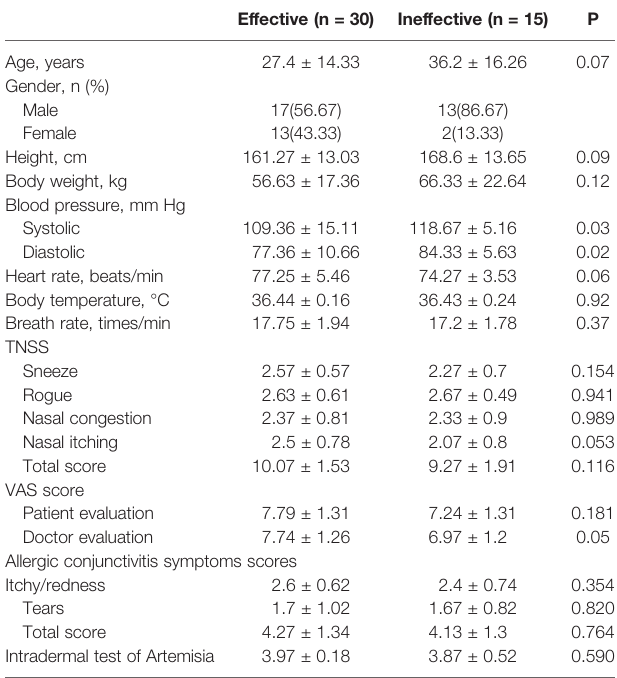
TABLE 1 | Baseline characteristics of